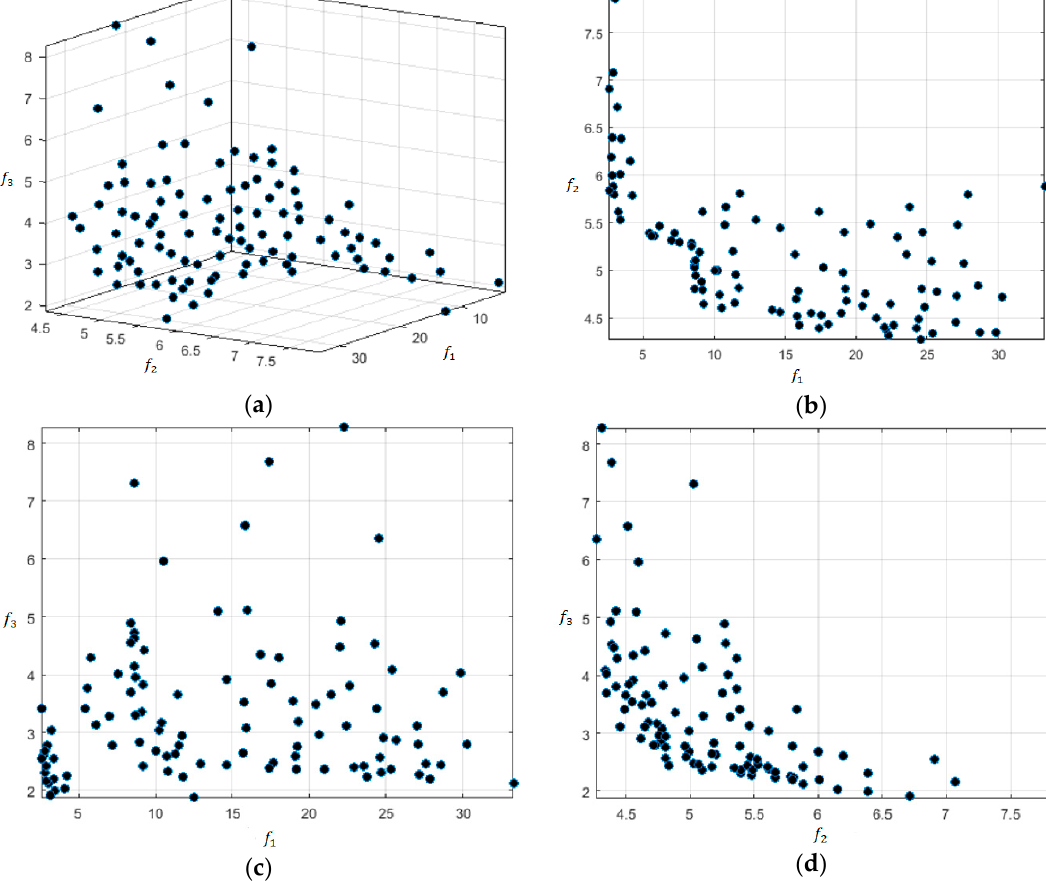
Figure 3. Visualization of Pareto Set No. 28: ( a ) Three objectives; ( b ) visualization of f 1 and f 2 ; ( c ) visualization of f 1 and f 3 ; and ( d ) visualization of f 2 and f 3 . Table 1. Results of 33 independent runs with the proposed method and the membership function values in the Pareto set for each run. The values higher than the average value of the corresponding objective function are highlighted in bold; and the superior results for the three objectives presented against a gray background.